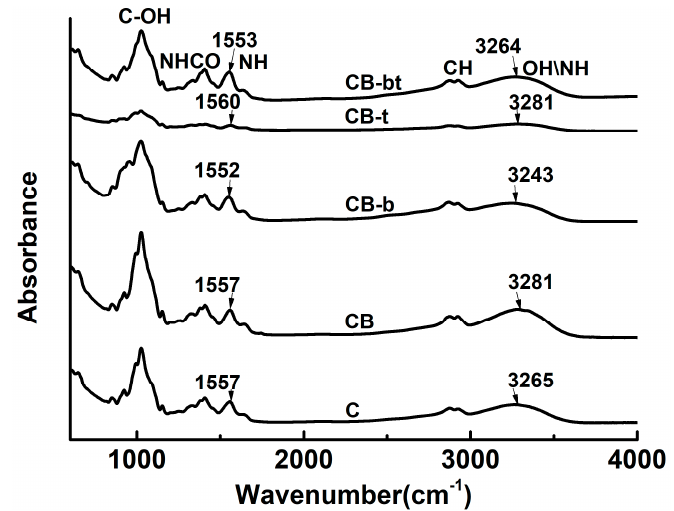
Figure 4. IR spectra of C, CB, CB-b, CB-t, and CB-bt.